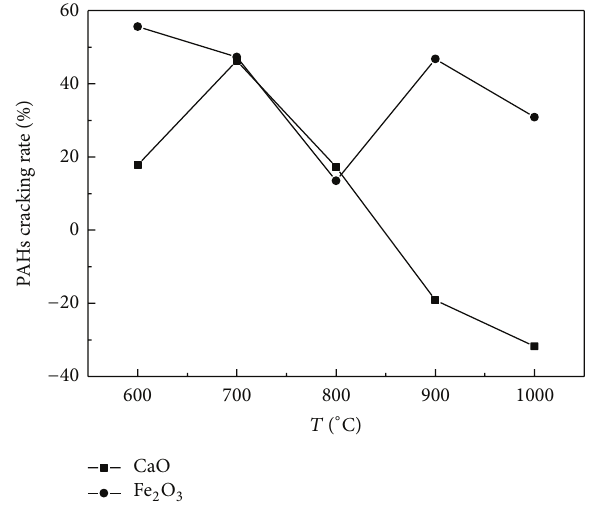
Figure 1: Relationship between the total PAHs cracking rate and temperature under effect of